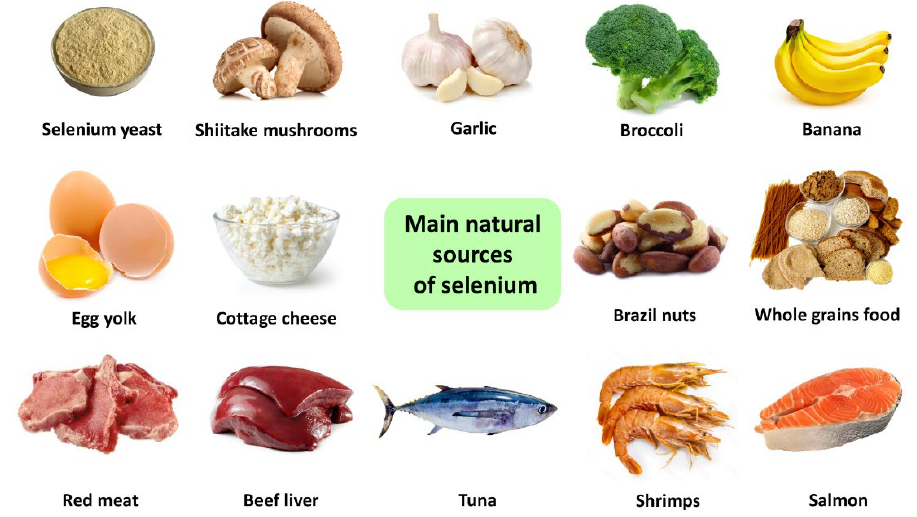
Figure 2. The key sources of Selenium from food.